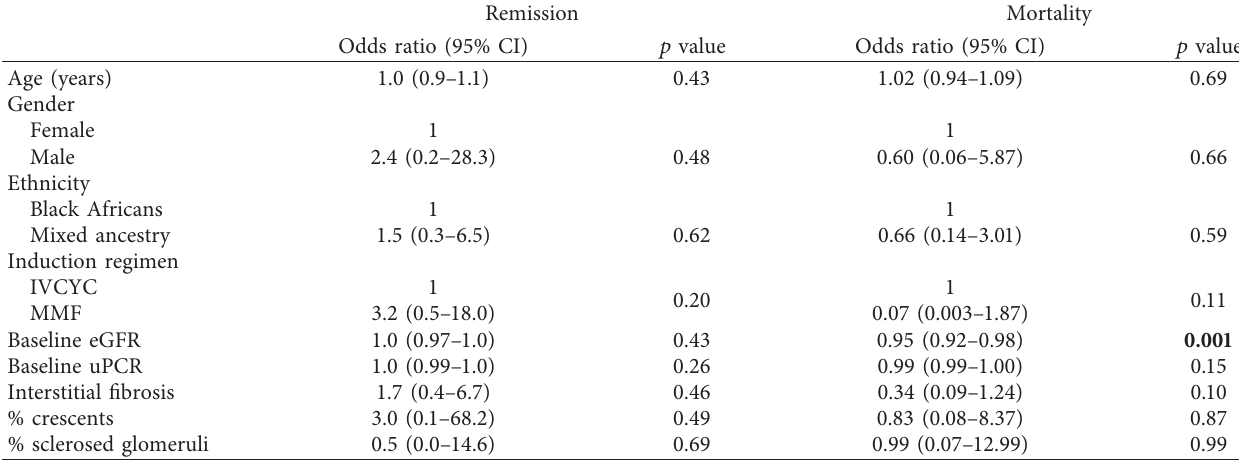
Table 4: Multivariable analysis for the predictors of remission and mortality.